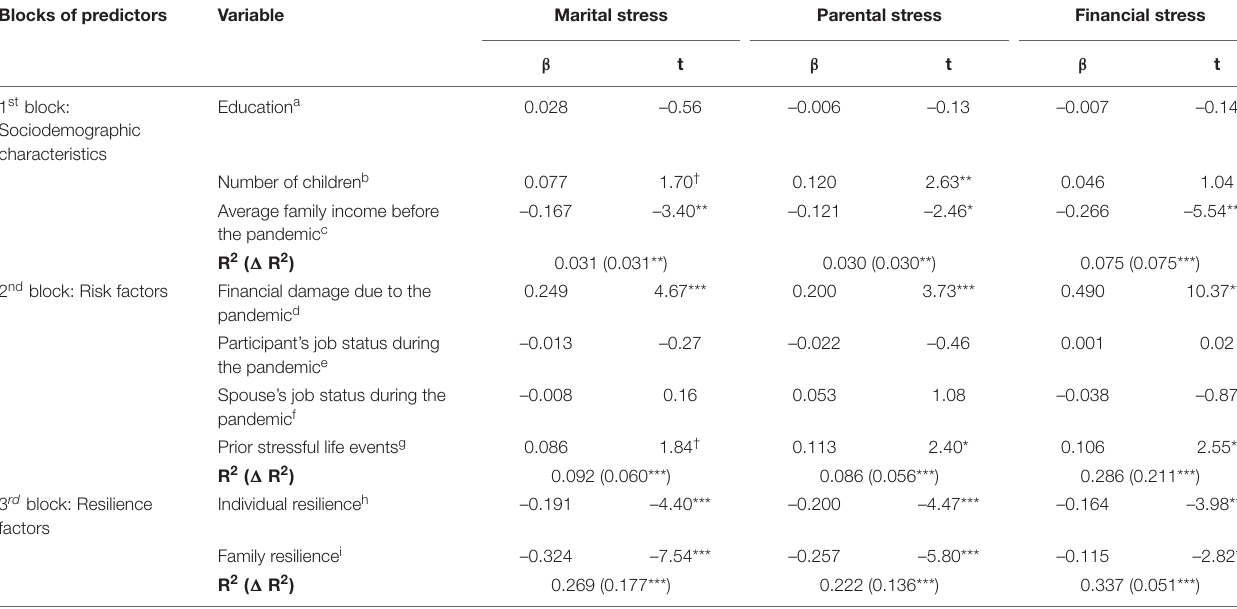
TABLE 4 | Summary of hierarchical multiple regression results for predicting marital stress, parental stress, and financial stress ( N = 477). Blocks of